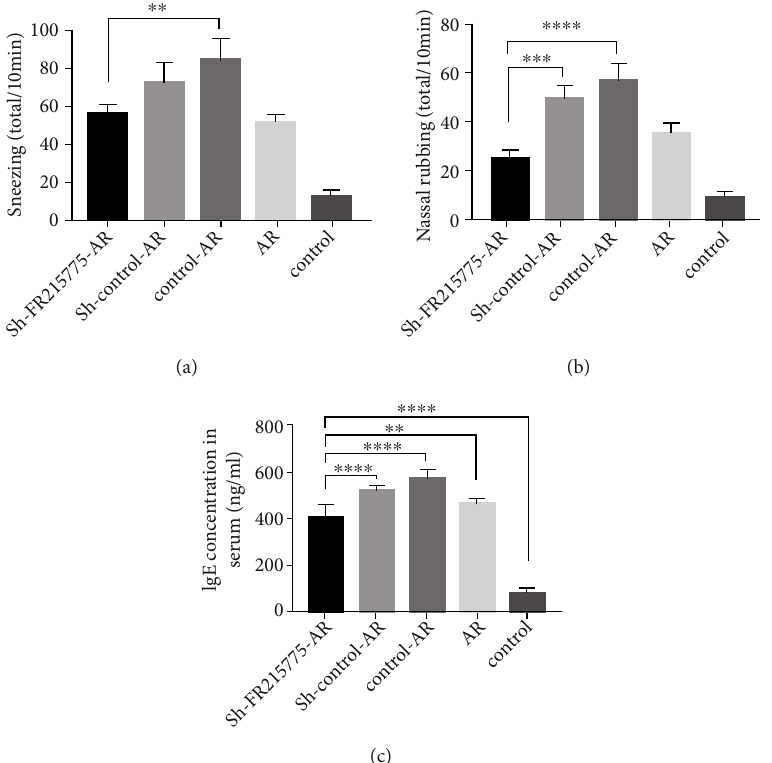
Figure 4: Symptoms scores and the serum IgE level in mice. (a, b) Symptoms of AR mice model can be ameliorated by lncRNA FR215775 silencing. Data represent the mean ± SD . (c) The serum IgE level was signi fi cantly reduced in sh-FR215775-AR group compared with the control AR group ( ∗∗ P < 0 : 01 , ∗∗∗ P < 0 : 001 , ∗∗∗∗ P < 0 : 0001